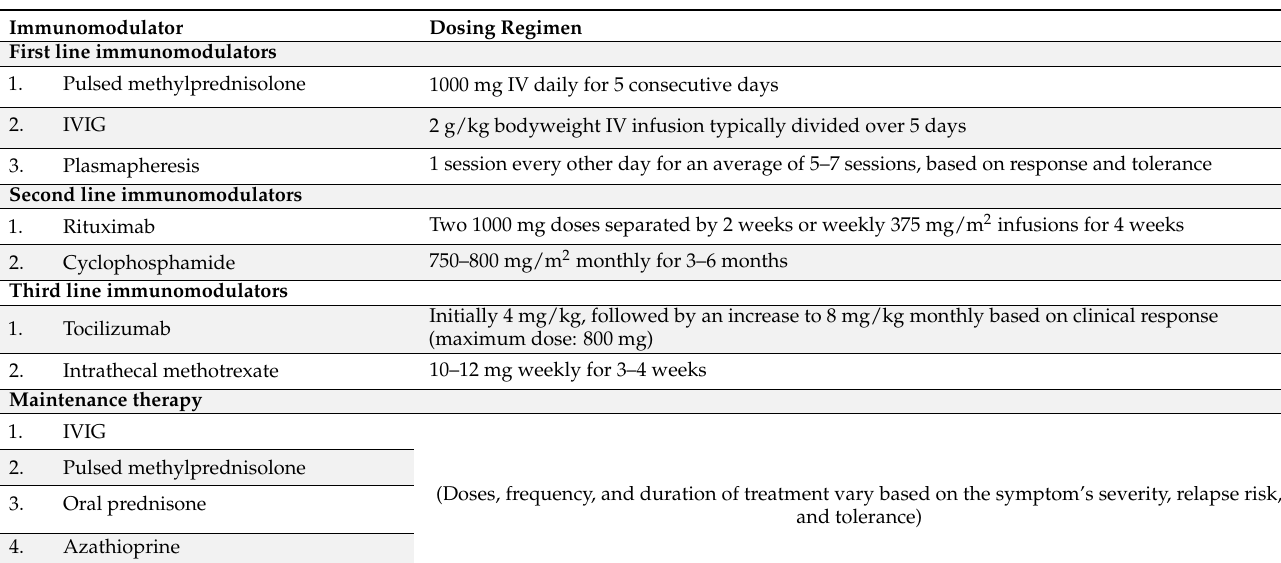
Table 4. Therapeutic options of autoimmune encephalitis